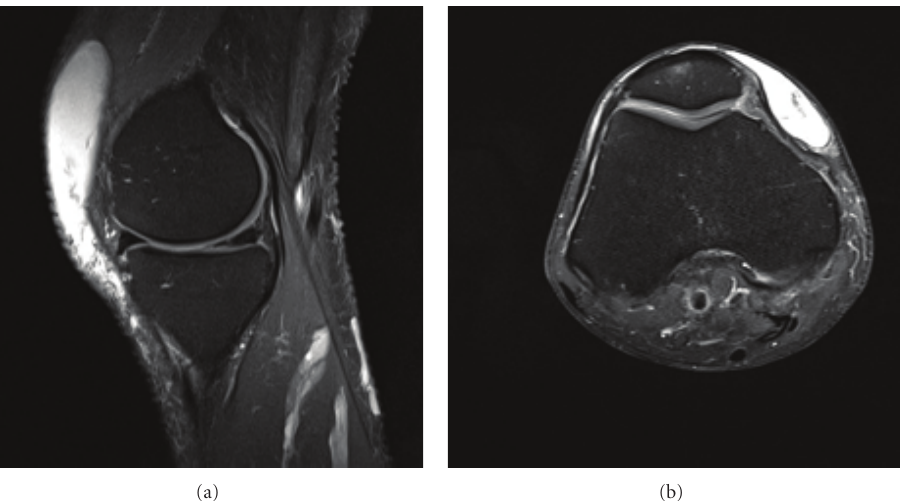
Figure 1: Magnetic resonance images (T2-weighted) highlighting the prepatellar collection of fluid in sagittal (a) and axial (b) sections. for which he underwent repeated aspirations of the bursa. On